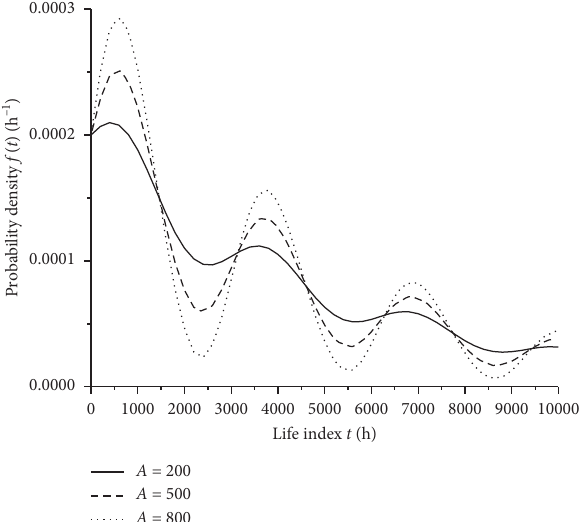
Figure 13: Effects of oscillation amplitude on probability density.